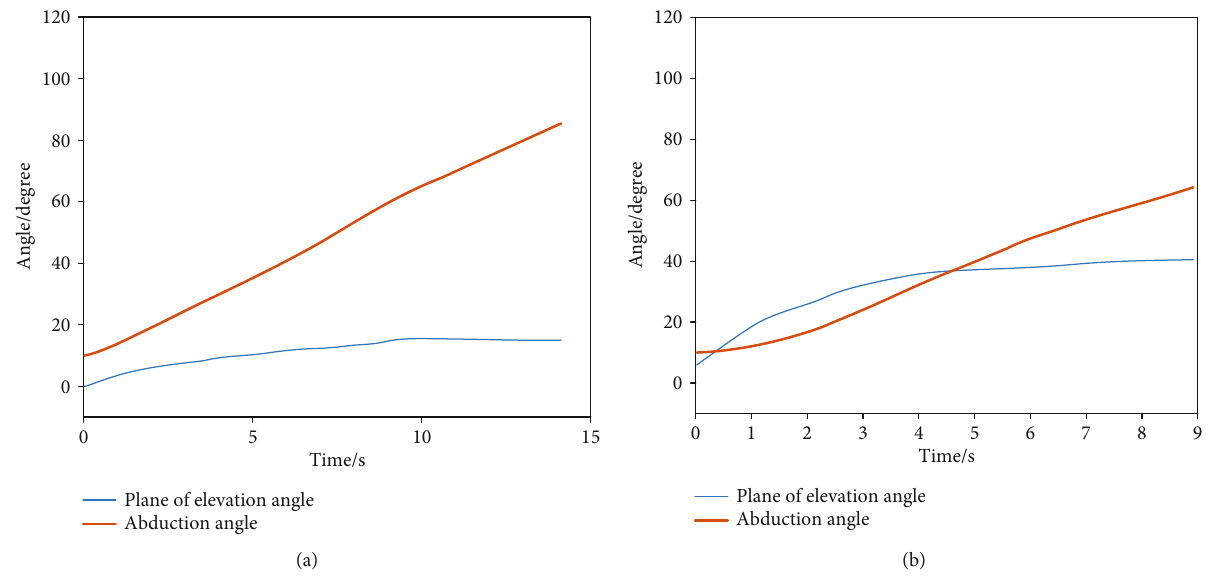
Figure 7: Globographic angle results. (a) Globographic angle of abduction in 0 ° plane of elevation. (b) Globographic angle of abduction in 30 ° plane of elevation.